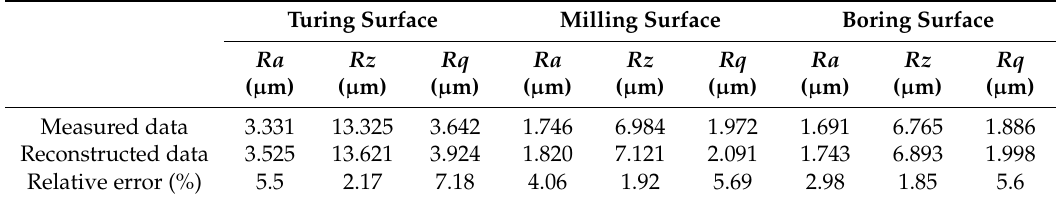
Table 2. The comparison results of profiles. Turing